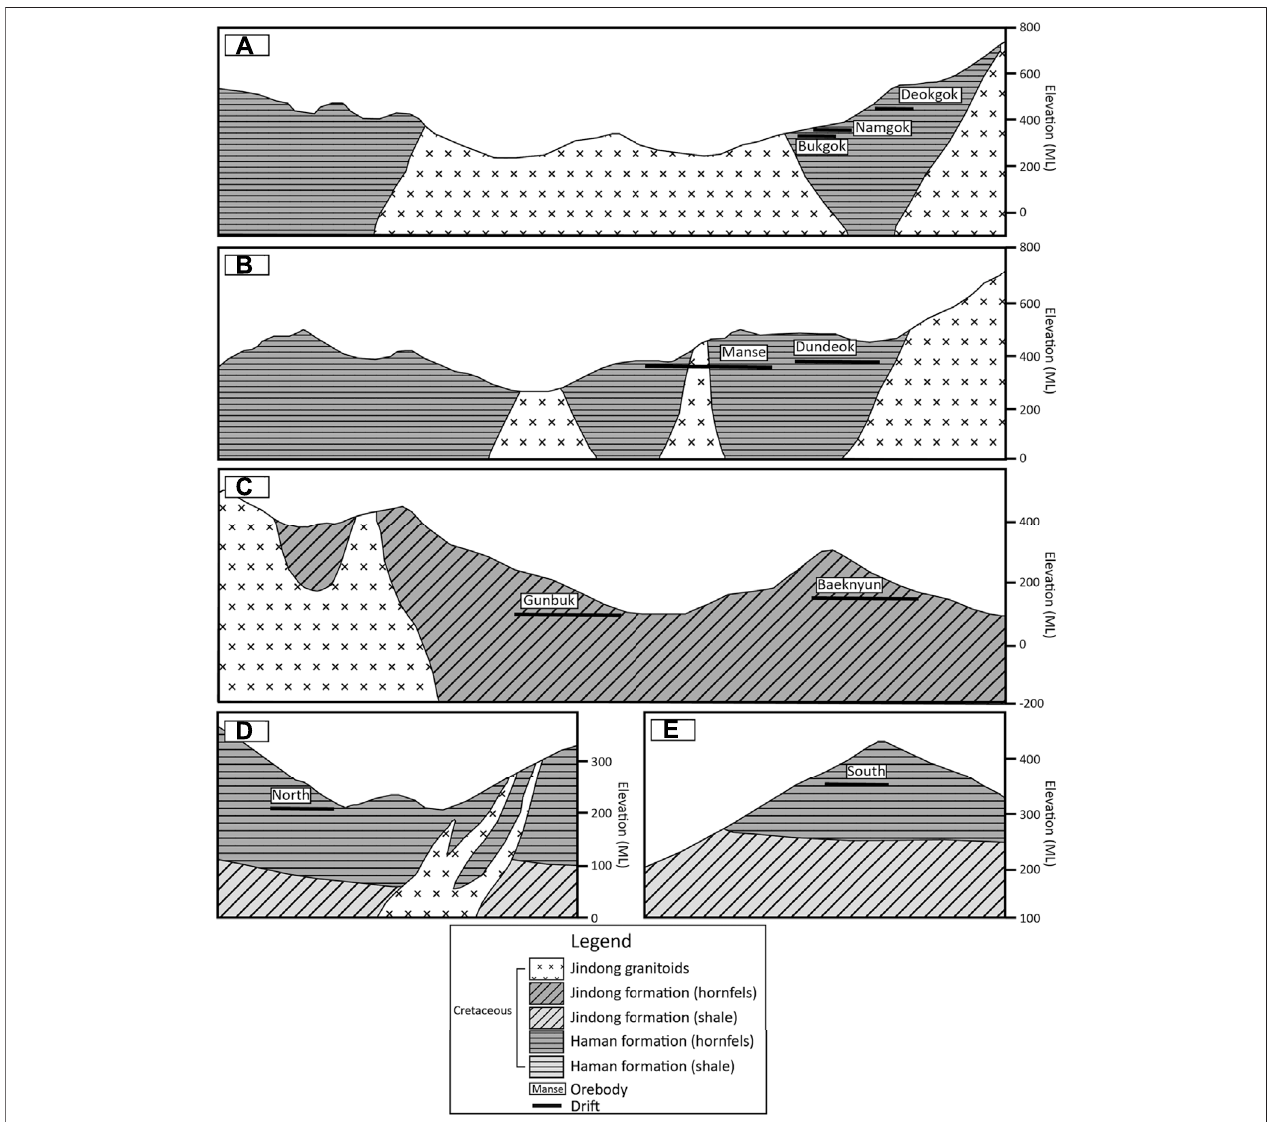
FIGURE 2 | Geologic cross-sections of the Haman, Gunbuk, and Daejang deposits. (A) Namgok-Bukgok orebody of the Haman deposit. The Ogok orebody is locatedneartheNamgok-BukgokorebodysurroundedbyJindong granitoids. (B) ManseandDundeokorebodyoftheHamandeposit. (C) Gunbuk-Baeknyunorebody of the Gunbuk deposit. (D) North orebody of the Daejang deposit. (E) South orebody of the Daejang deposit. The maps are modi fi ed versions of those produced by Moon et al. (1986), Kim et al. (2016b).